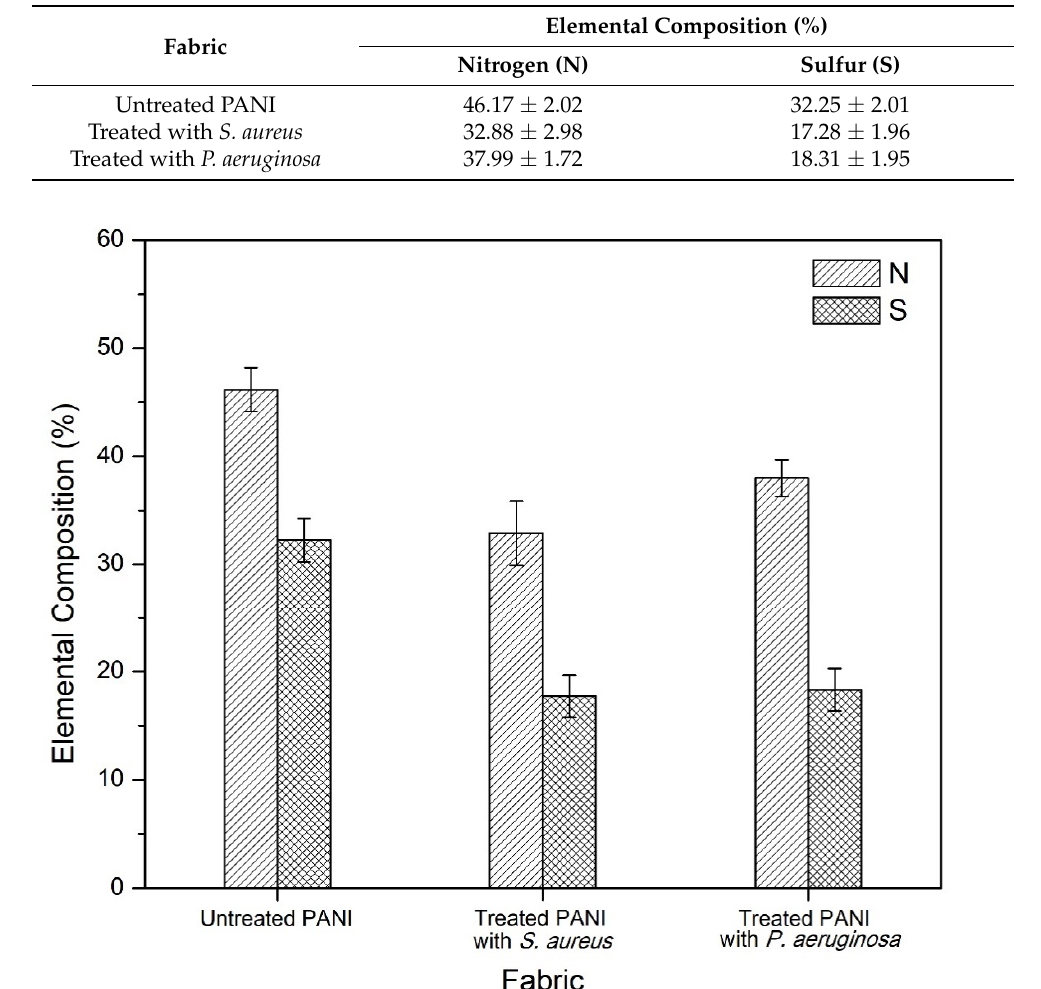
Table 4. Elemental compositions of nitrogen (N) and sulfur (S) in untreated PANI fabric, and in PANI fabric treated with S. aureus and P. aeruginosa .